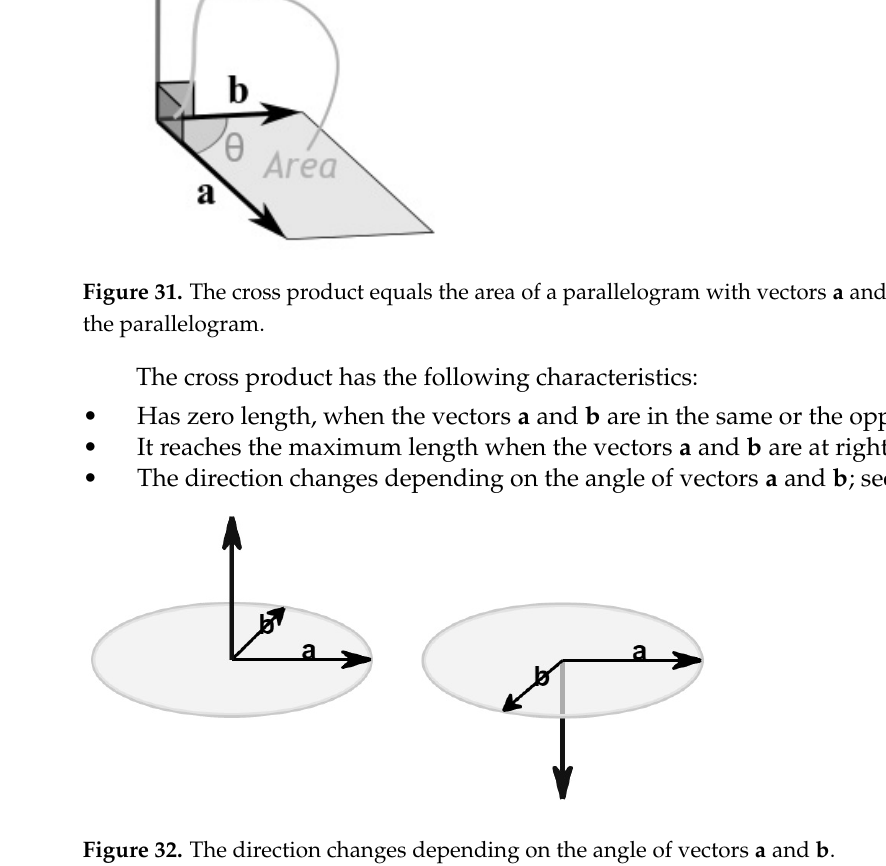
Figure 32. The direction changes depending on the angle of vectors a and b